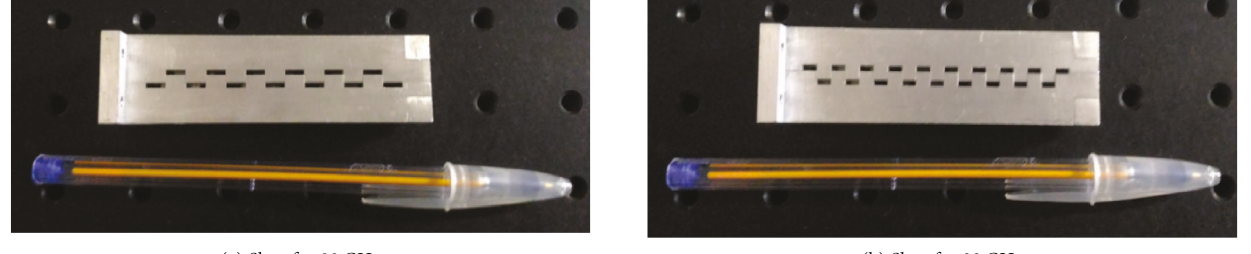
Figure 10: Dual-band slotted waveguide antenna array.